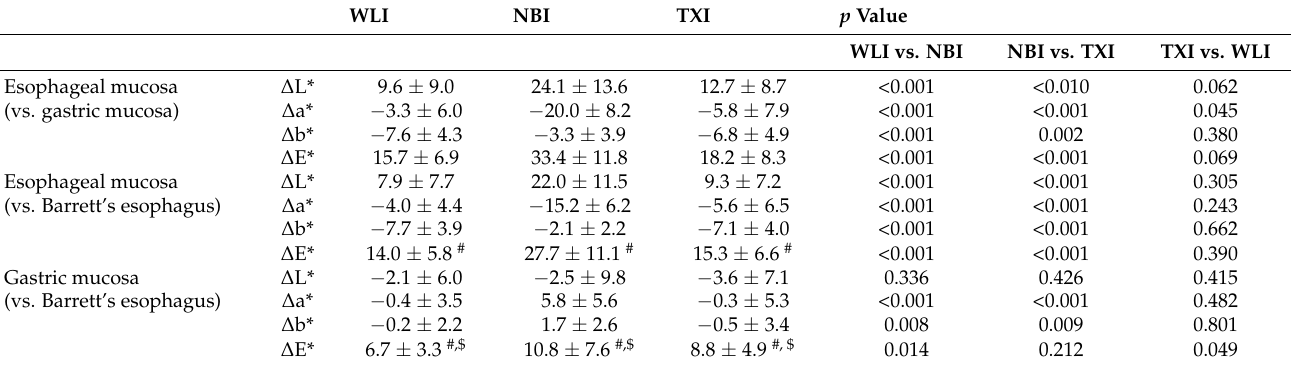
Table 3. Color differences among esophageal mucosa, gastric mucosa, and SSBE.